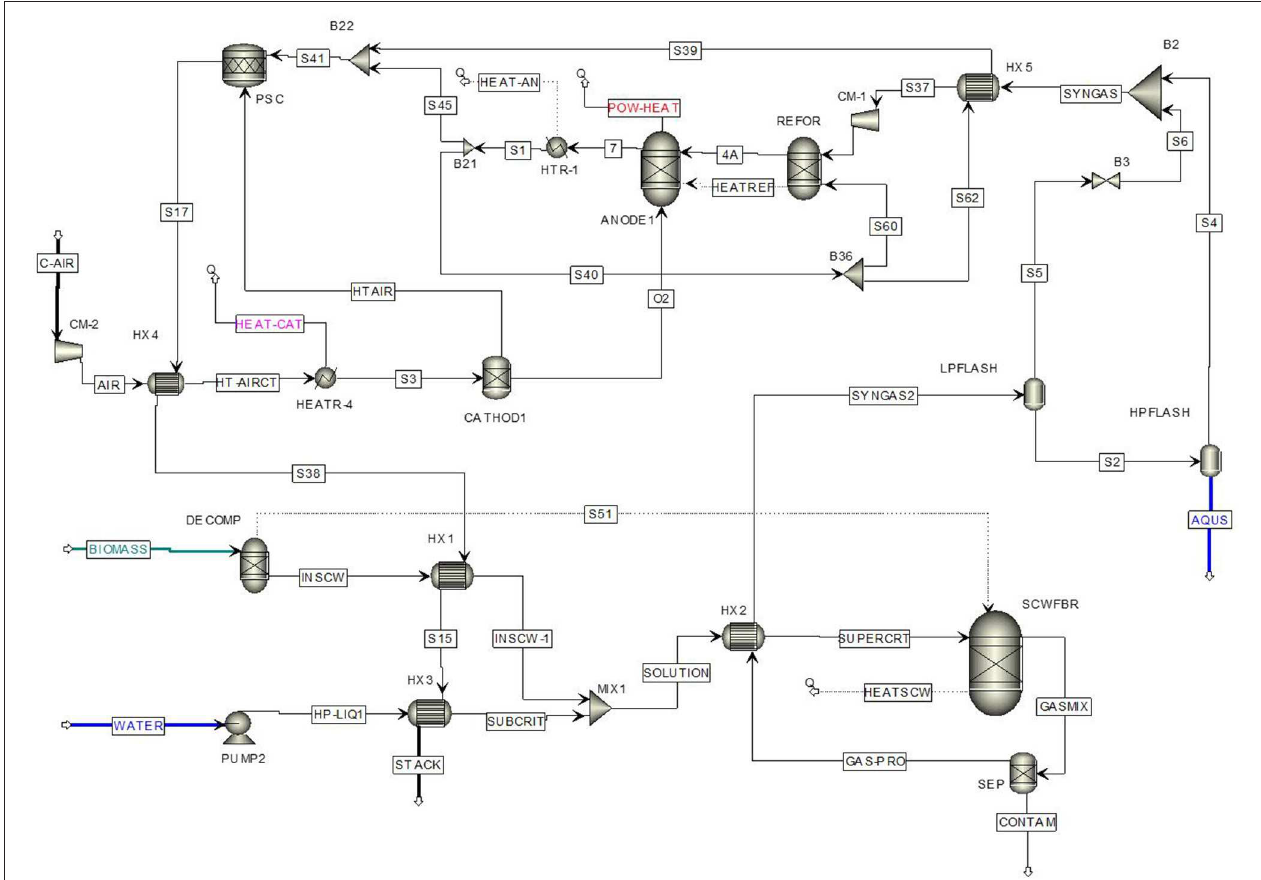
FIGURE 3 | Aspen Plus process flow diagram of the supercritical water gasification (SCWG)-solid oxide fuel cell (SOFC)